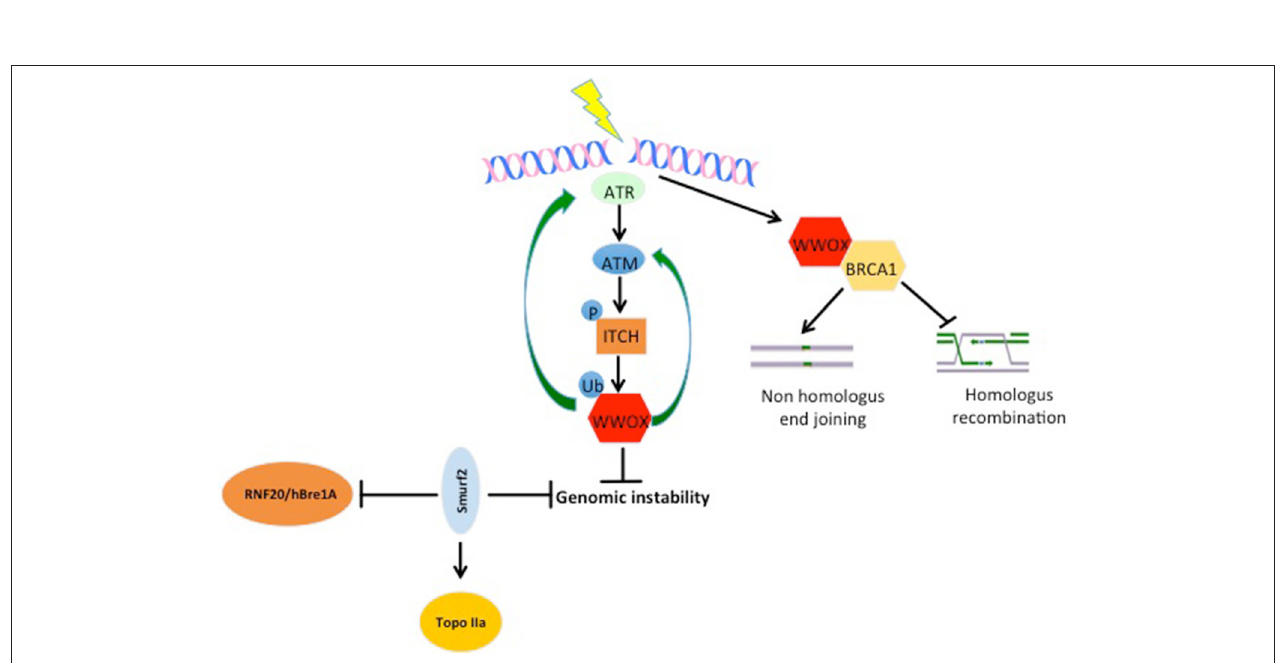
FIGURE 2 | WW domain protein roles in genomic stability. Upon DNA damage, ATR and ATM get activated. When activated, they can phosphorylate and activate the E3 ligase ITCH. Active ITCH can further ubiquitinate and activate WWOX leading to its translocation to the nucleus. In the nucleus, WWOX, in a positive feedback loop activates ATM and ATR and enhances DNA damage response and repair. Moreover, WWOX can interact with BRCA1 and enhance Non-homologous end joining over homologus recombination repair pathway . E3s also play roles in genomic stability too . SMURF2 increase genomic stability by inhibiting the activity of RNF20/hBre1A, the major ubH2B-specific E3 and by stabilizing topoisomerase IIa (Topo IIa). ITCH enhances genomic integrity by increasing the efficiency of DNA damage repair (DDR). Upon DNA damage ITCH is activated by ATM. Active ITCH can further ubiquitinate and activate WWOX leading to its translocation to the nucleus. In the nucleus, WWOX, in a positive feedback loop, activates ATM and ATR and enhances DNA damage response and repair.